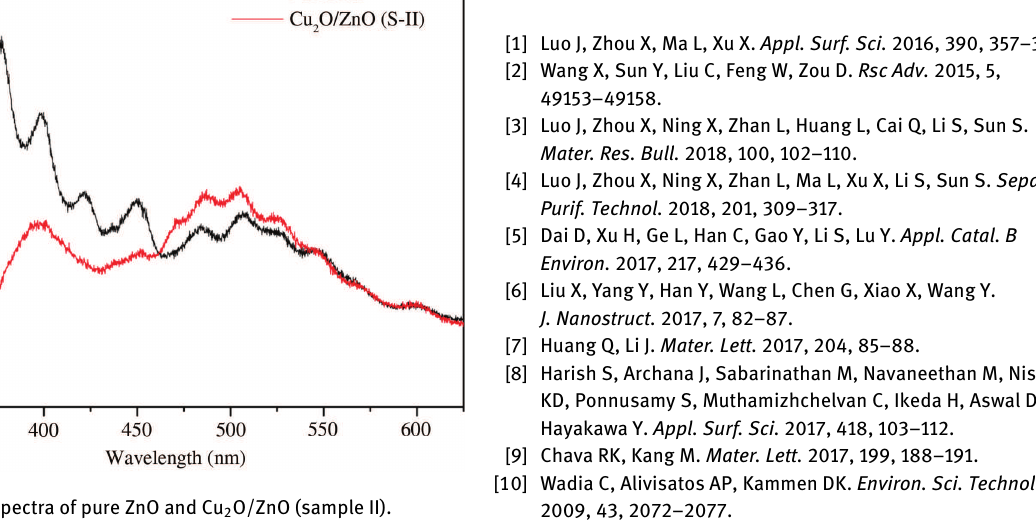
Figure 14: PL spectra of pure ZnO and Cu 2 O/ZnO (sample